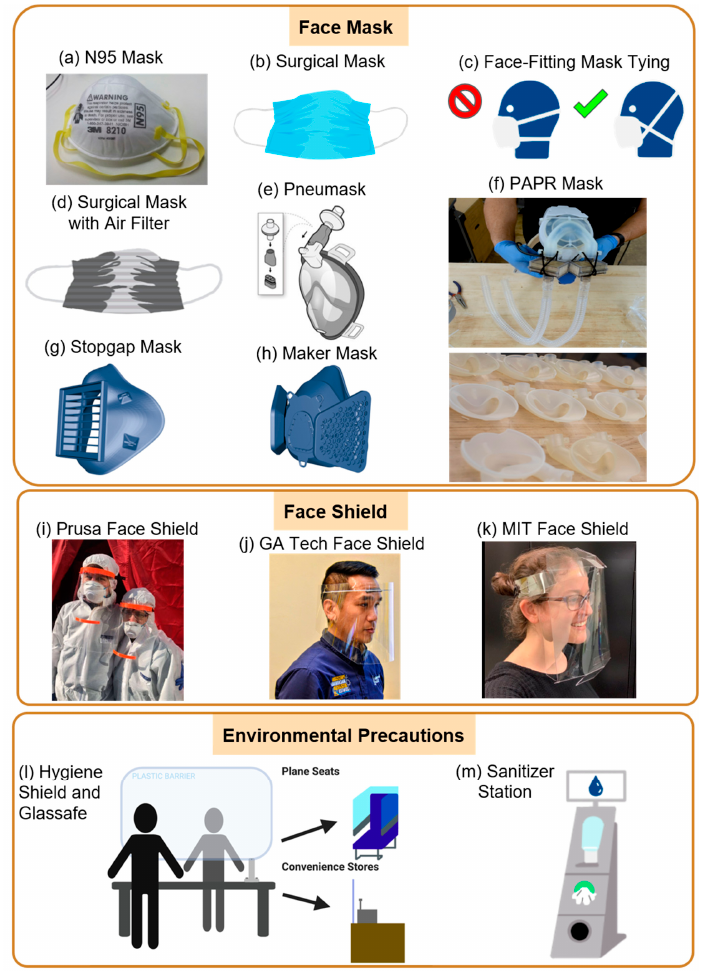
Figure 3 . Protection tools against COVID-19 in the form of face masks, shields, and sanitizers. ( a ) The N95 Respirator is Food and Drug Administration (FDA)-approved and is currently the best-known form of personal protective equipment (PPE) available to healthcare professionals; ( b ) FDA-approved surgical masks are to be used by healthcare workers in the absence of N95 respirators; ( c ) The regular method for tying surgical masks compared to the newly proposed method that can secure the side openings of surgical masks; ( d ) A surgical mask design modified with filter performance rating (FPR) 9-10 air-conditioning filters; ( e ) The Stanford full-face, snorkel-inspired Pneumask. The Pneumask has deployed 2600 units all across the United States (US), with concentrations in New York, Massachusetts, and California; ( f ) The team at Duke has fully modified a powered air-purifying respirator (PAPR) design, which is attached to the surgical helmets (left) and the 3D-printed component of the PAPR (right); ( g ) The 3D printable Stopgap Mask from the Veterans Health Administration that is approved by the FDA to protect clinical personnel from COVID-19; ( h ) The 3D printable Maker Mask that can be used by non-clinical personnel when there are no FDA-approved masks available; ( i ) The Prusa Printer face shield that can be used to protect clinical personnel when no FDA-approved face shields are available; ( j ) The Georgia Tech 3D-printed rigid frame and a disposable face shield design; ( k ) The MIT origami disposable face shield. The Georgia Tech and MIT labs have collaborated to produce almost one million face shields to be used by hospitals around the US; ( l ) An illustration of the transparent acrylic barrier concept for public settings where cross-contamination is frequent. Aviointeriors has designed a possible solution for plane seats, while Safetell and Umdasch have designed and implemented their solution for retail stores; ( m ) The sanitizer station is a representation of the Umdasch Hygiene Station that could be distributed to all types of public facilities in the future as a